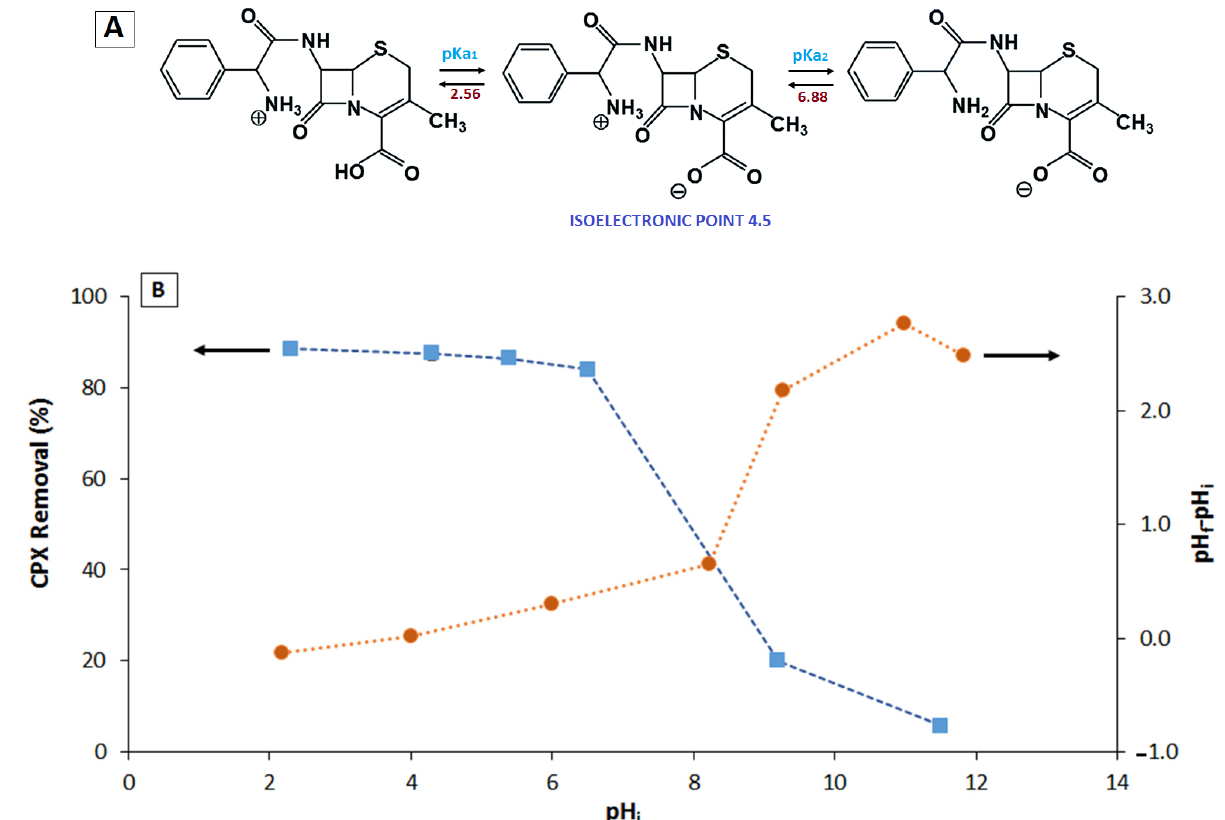
Figure 3. ( A ) Cephalexin ionization states and ( B ) (left) the effect of the solution pH on the CPX removal using F Zn (adsorption conditions (CFX): 20 mg L − 1 , adsorbent doses: 1.6 g L − 1 , time: 60 min); ( B ) (right) point of zero charge (PZC) for the material.